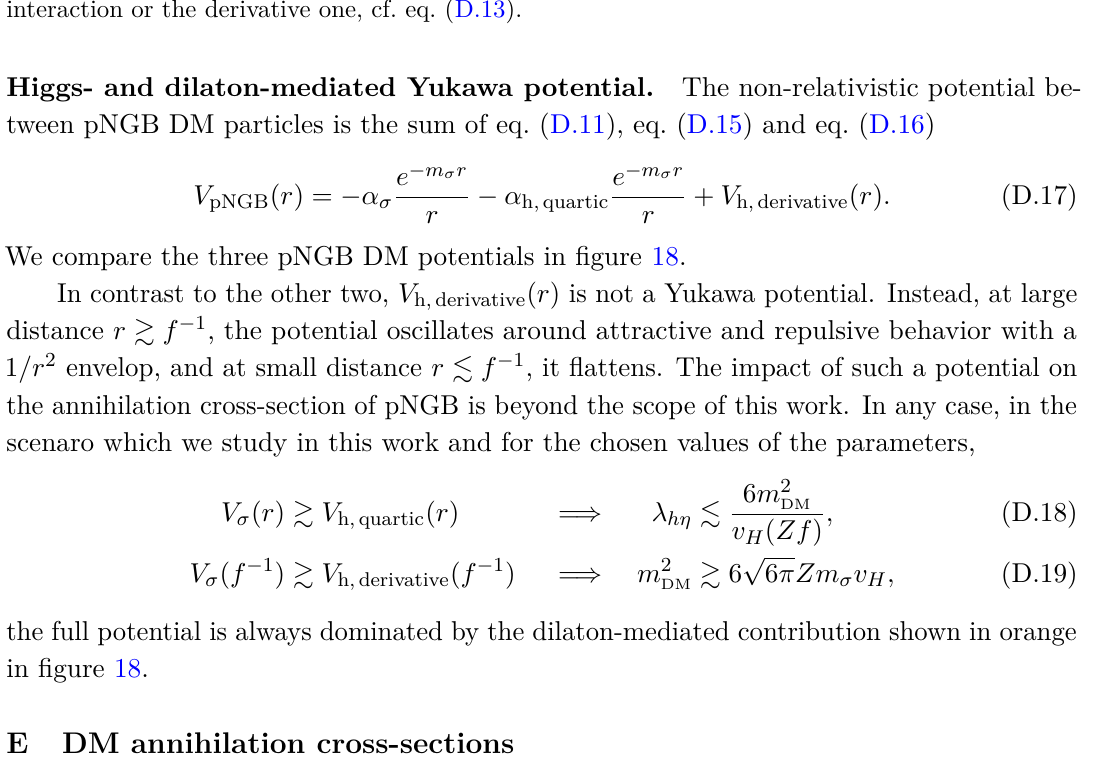
Figure 18 . Non-relativistic potentials between 2 pNGN DM particles assuming either the dilaton- mediated channel or the Higgs-mediated channel. In the later case, we consider either the quartic interaction or the derivative one, cf. eq.